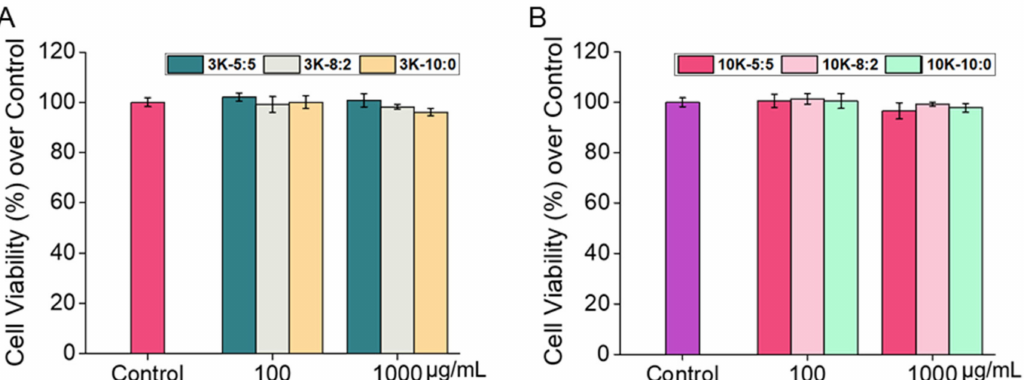
Figure 5. Effects of ( A ) CNS3Ks and ( B ) CNS10Ks on the viability of human dermal fibroblasts as assessed using a CCK-8 assay after incubation at 37 ◦ C for 24 h. Shown are the means ± standard deviation ( n =